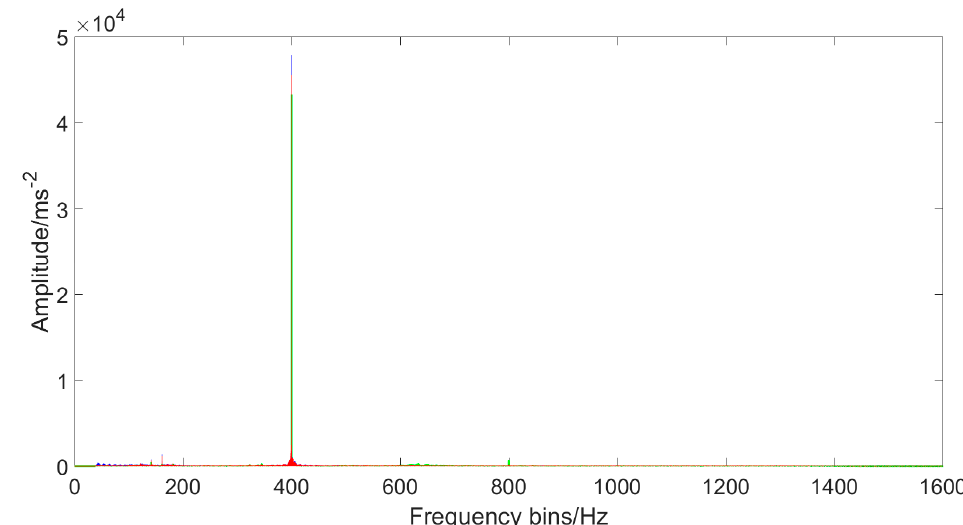
Figure 8. Frequency responses of the three channels identified to have the largest average responses in the system within the time window analysed, which was 5 s in the example and shows a dominant excitation input with a frequency of 400 Hz.